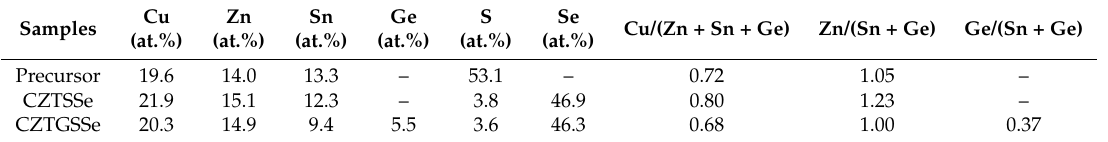
Table 1. Composition of the precursor film, CZTSSe film, and CZTGSSe film.